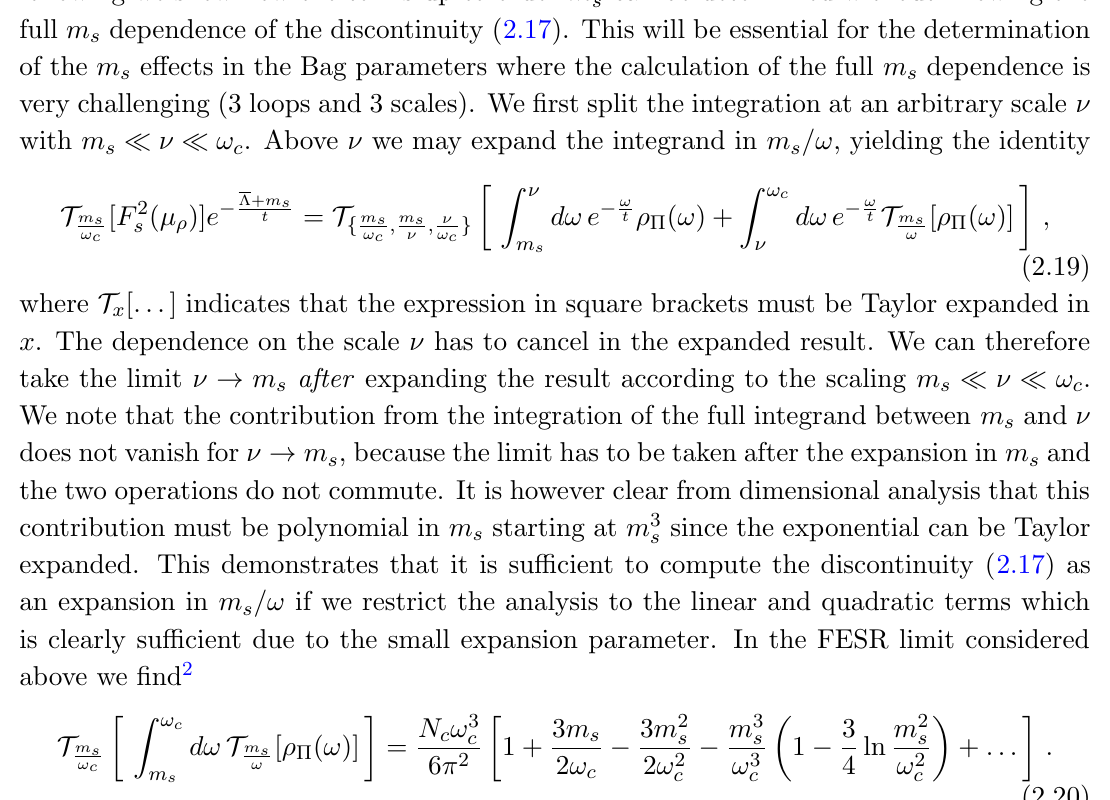
Figure 1 . Sample diagram involving a soft light-quark propagator (red thick